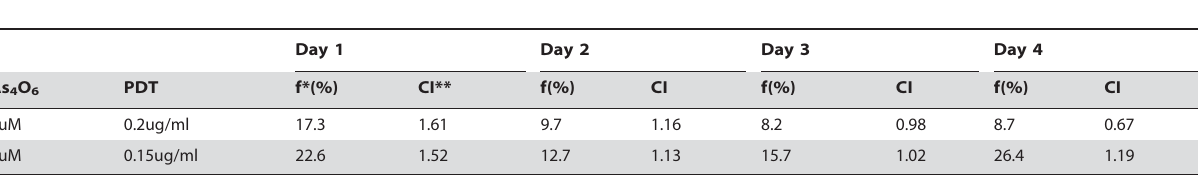
Table 1. Combination index (CI) values for TC-1 cells treated with Radachlorin/PDT and As 4 O 6